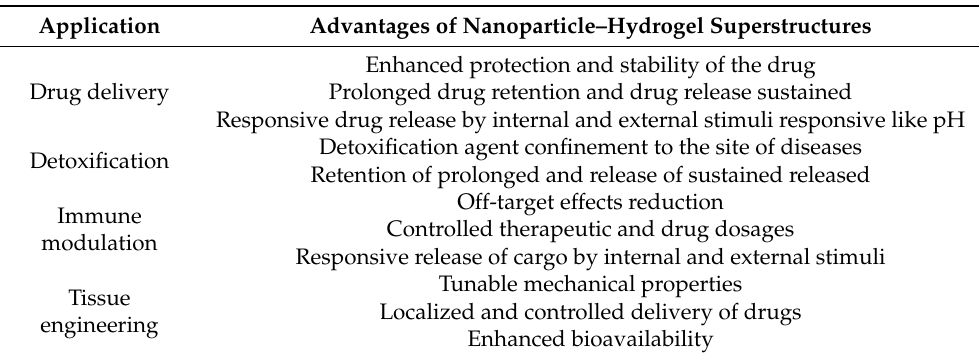
Table 3. Advantages of a nanoparticle–polysaccharide hydrogel for biomedical uses